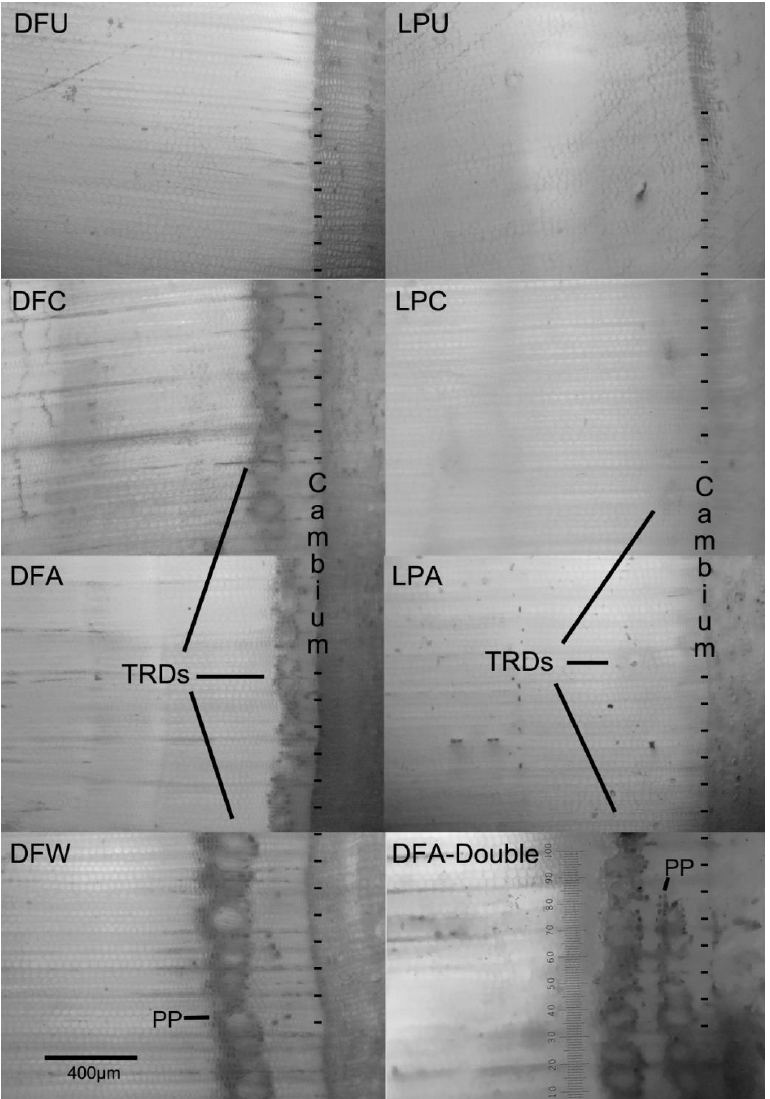
Figure 2. Cross sections of Douglas-fir (DF, left ) and lodgepole pine (LP, right ) inoculation zones. Phloem aligned to the right. U = Untreated , C = Control, A = Aggressive, and W = Weak, PP = polyphenolic parenchyma. Cambium is indicated by the word Cambium written vertically and dashes. Lower right panel shows a double line of TRDs formed in response to the Aggressive fungal suite. All induced resin ducts are indicated as TRD for